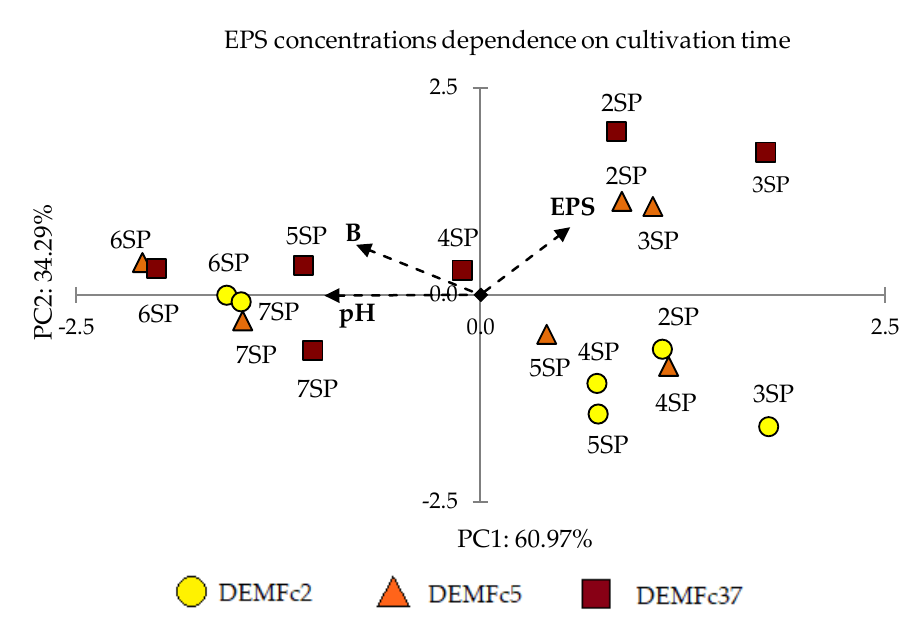
Figure 5. Principal component analysis (PCA) - dependence of EPS concentrations (EPS), fungal dry biomass (B), and pH values in post-culture liquid on the cultivation time in cultures of F. culmorum strains with sucrose (S) and peptone (P) as an C and N source, respectively.